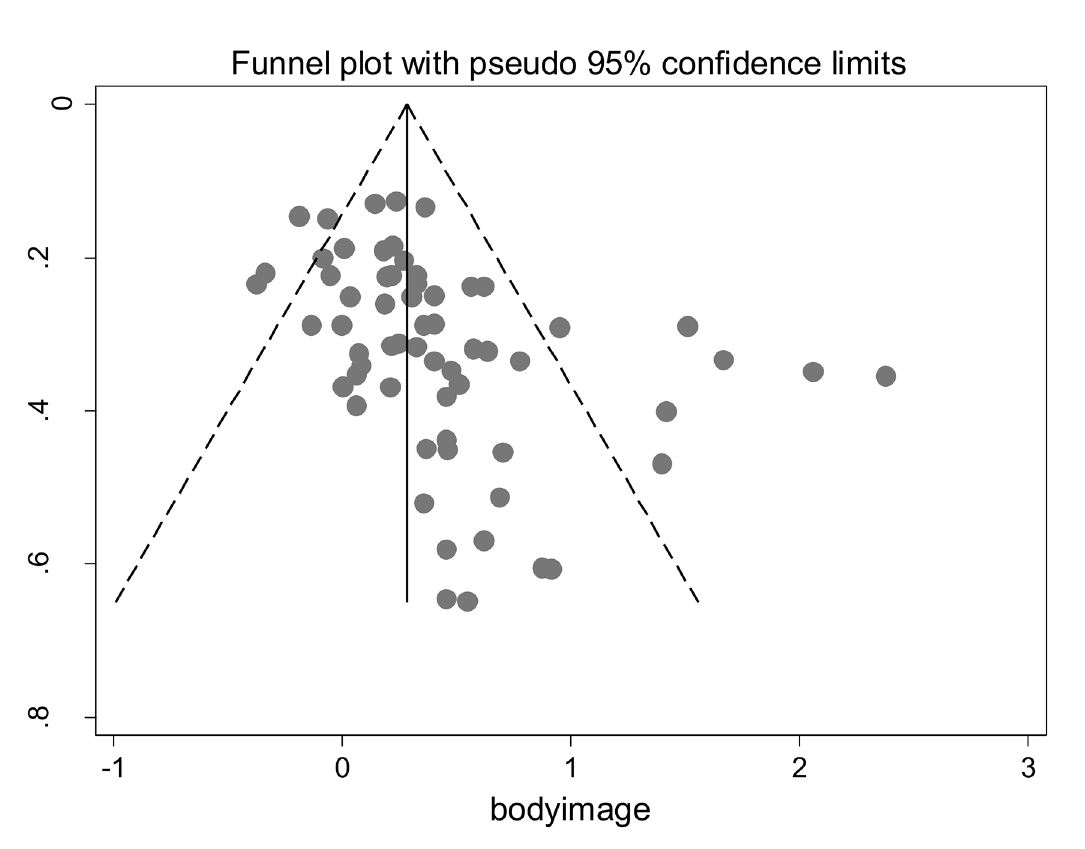
Fig 2. Funnel Plot of Effect Sizes (d + ) for Body Image. s.e. = standard